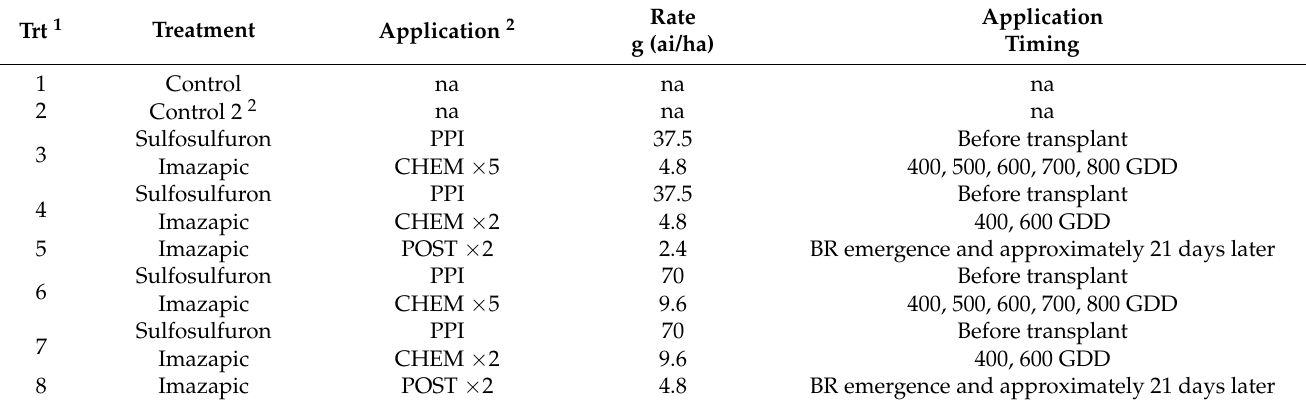
Table 7. 2019 and 2020 tomato crop safety treatment list.